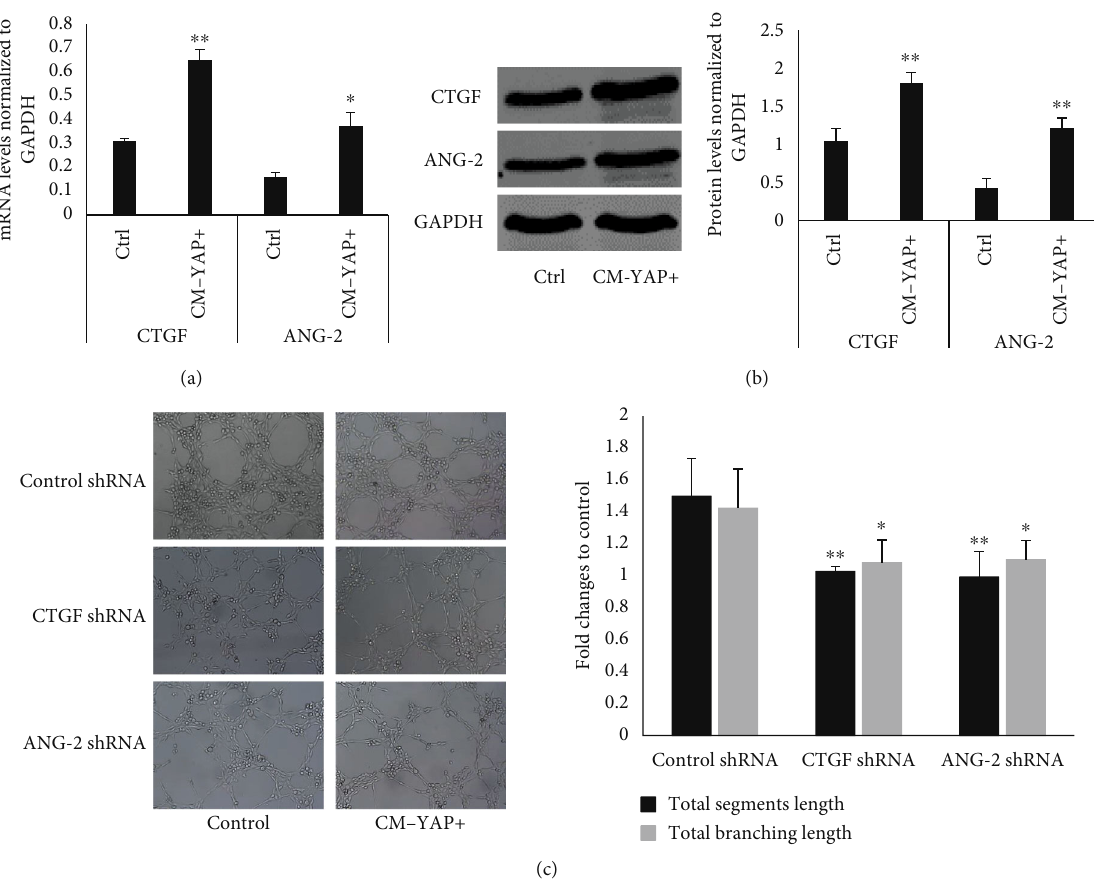
Figure 5: Connective tissue growth factor and angiopoietin-2 acted as down-stream of YAP in HUVECs to promote tube formation. (a) HUVECs were starved for 16 hr, then, treated with CM for 12 hr. The mRNA levels of CTGF and ANG-2 in HUVECs were determined by quantitative real-time PCR. Normalized expressions values are were quanti fi ed with mean ± SD from three independent experiments ∗ p < 0 : 05 . ∗∗ p < 0 : 01 . (b) HUVECs were starved for 16 hr, then, treated with CM for 12hr. The protein levels of CTGF and ANG-2 in HUVECs were determined by Western blot. Representative results are shown from three independent experiments. ∗∗ p < 0 : 01 . (c) HUVECs were transfected with di ff erent siRNAs for 48hr, starved and then, treated with CM for 12hr. The total segment length and total branching length from tube formation assay were quanti fi ed with mean ± SD from six independent representative fi elds. ∗ p < 0 : 05 . ∗∗ p < 0 : 01